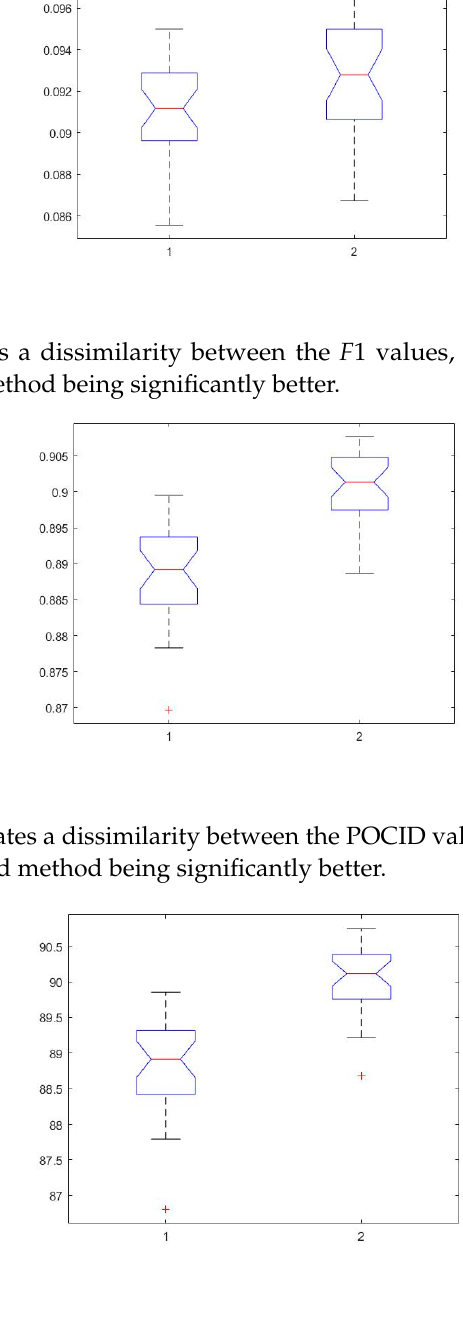
1. MAPE indicator. The result indicates a similarity between the MAPE values.